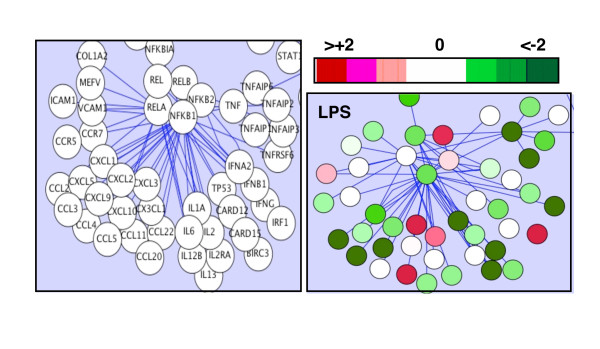
Differentially expressed genes in LPS-stimulated IRAK4-deficient monocytes downstream of NFκB. Using the open-source bioinformatics visualization software Cytoscape [31] gene expression in LPS-stimulated, IRAK4-deficient monocytes was overlayed on the TLR4 signal transduction pathway downstream of NFκB. Gene names are given in the left panel and gene expression in the right panel. The relative expression of the gene in IRAK4-deficient monocytes is depicted by the colour of the nodes on the protein map; green nodes indicate lower expression and red nodes indicate higher expression in IRAK4-deficient monocytes relative to that in a control pool of monocytes.